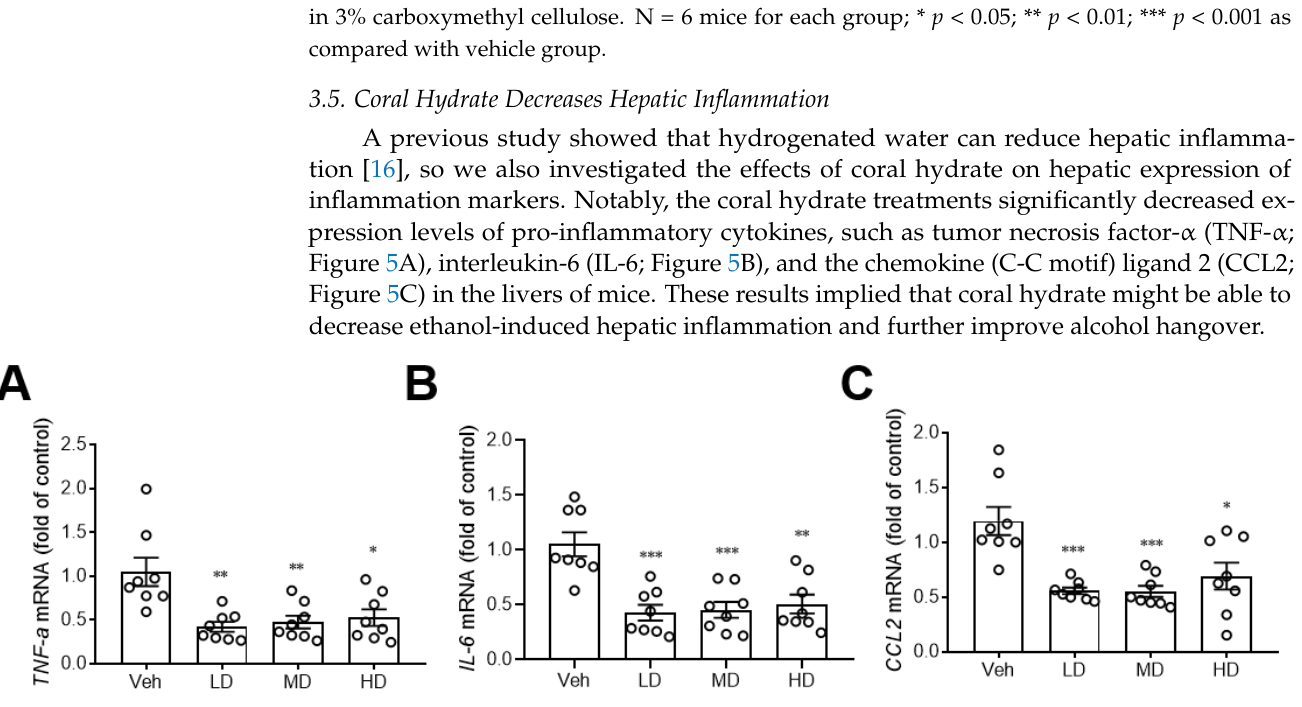
Figure 5. Coral hydrate attenuates ethanol-induced hepatic expression of inflammation markers. Coral hydrate was administered to mice via oral gavage for seven days before the intraperitoneal injection of ethanol for each group of the mice. Two hours after the injection of ethanol, liver tissues were removed for the determination of tumor necrosis factor- α (TNF- α ) ( A ), interleukin-6 (IL-6) ( B ), and chemokine (C-C motif) ligand 2 (CCL2) ( C ) gene expression levels by RT-PCR. Low dose group (LD), 105 mg/kg coral hydrate; Medium dose group (MD), 210 mg/kg coral hydrate; High dose group (HD), 420 mg/kg coral hydrate; vehicle group (Veh), 420 mg/ kg coral calcium dissolved in 3% carboxymethyl cellulose. N = 6 mice for each group; * p < 0.05; ** p < 0.01; *** p < 0.001 as compared with vehicle group.